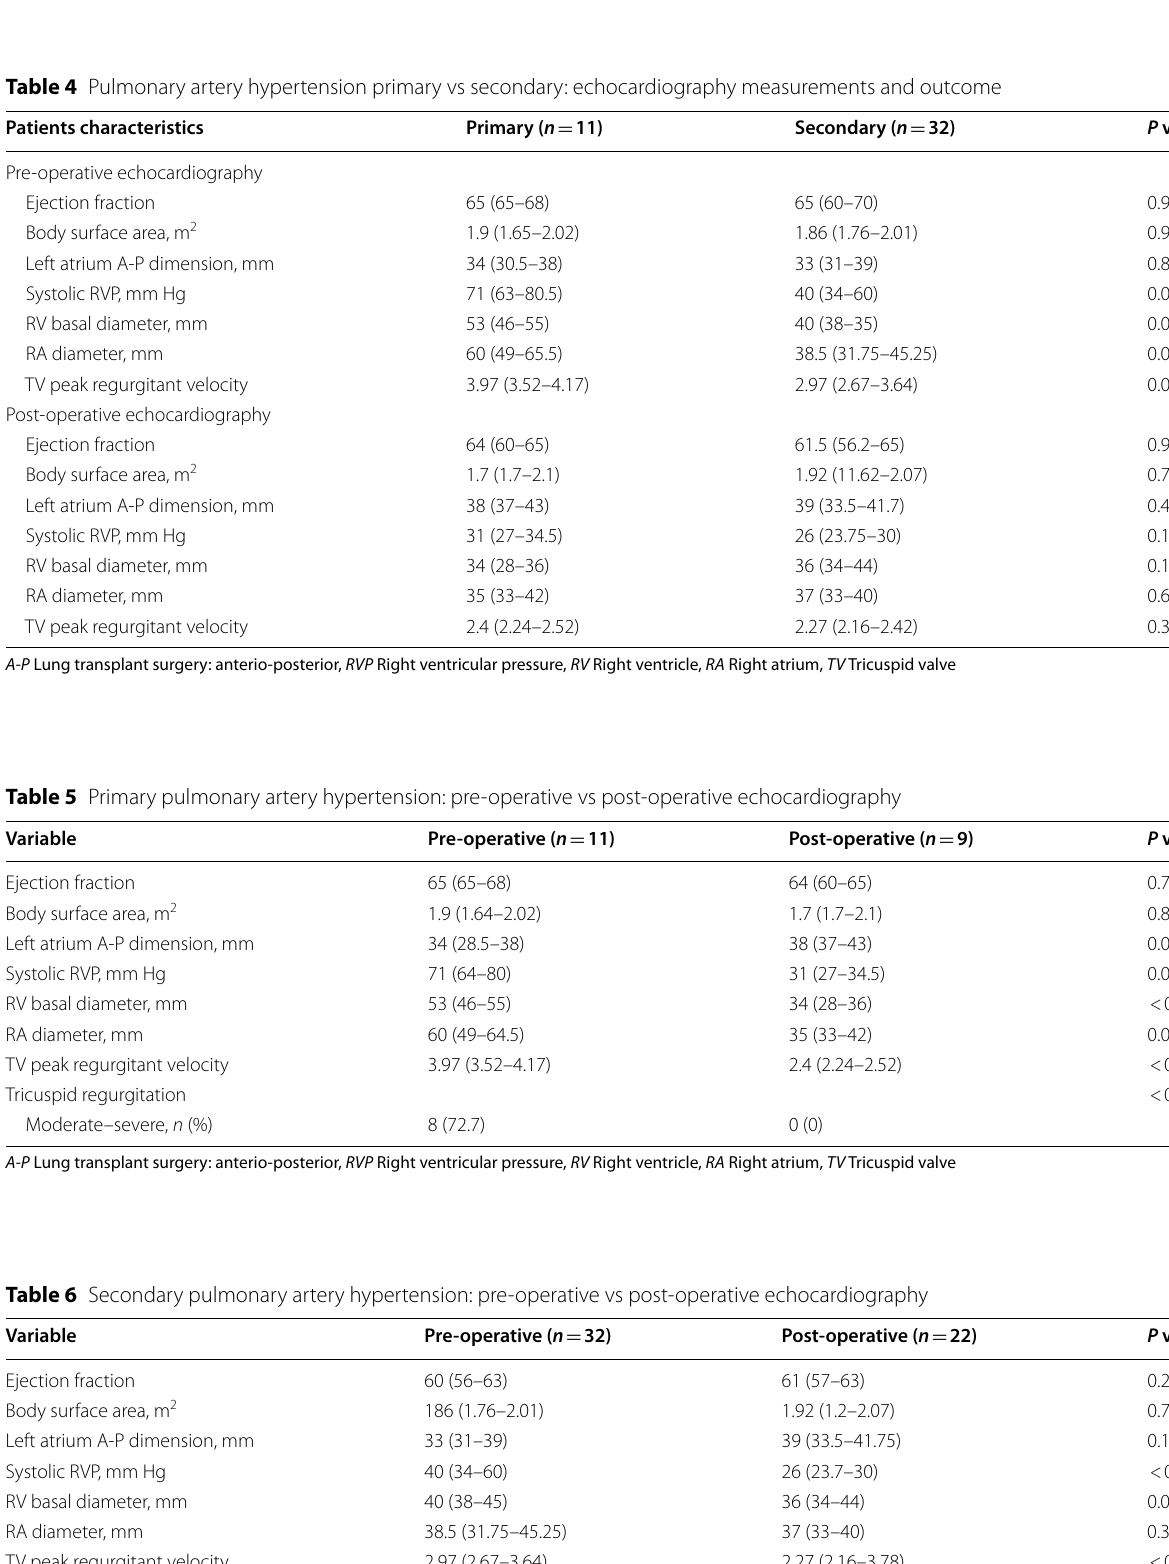
A-P Lung transplant surgery: anterio-posterior, RVP Right ventricular pressure, RV Right ventricle, RA Right atrium, TV Tricuspid